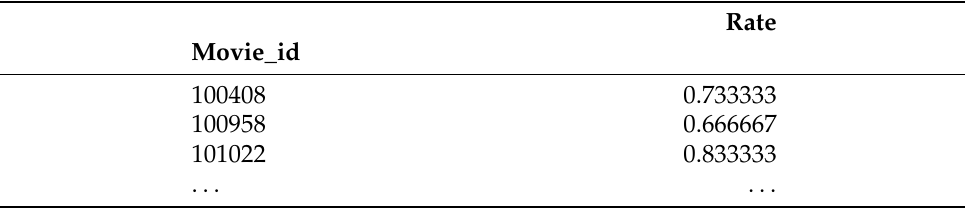
Table 5. Array with movie predictions for the selected user according to users with high affinity. The shape is (2831), where 2831 is the number of movies.